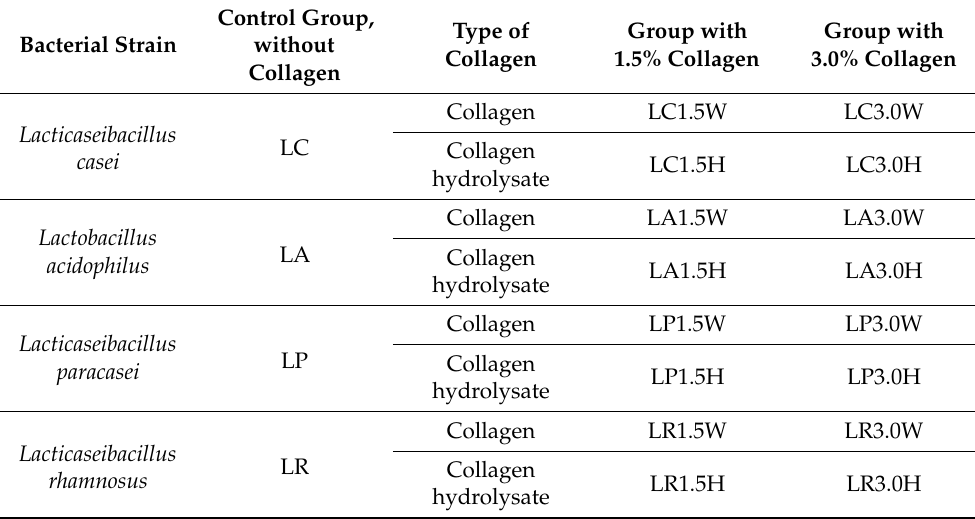
Table 7. Milk groups obtained in the